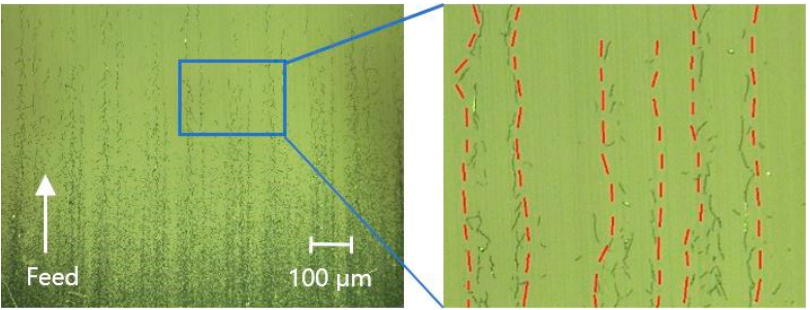
Figure 18. SSD extending along grinding marks.